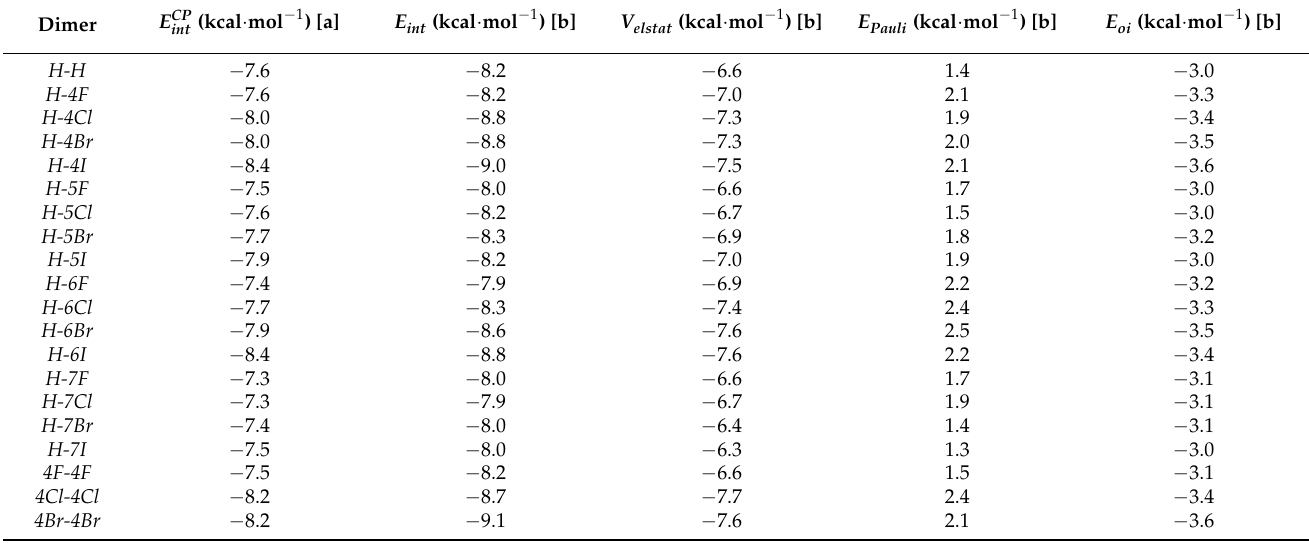
) are computed at the int